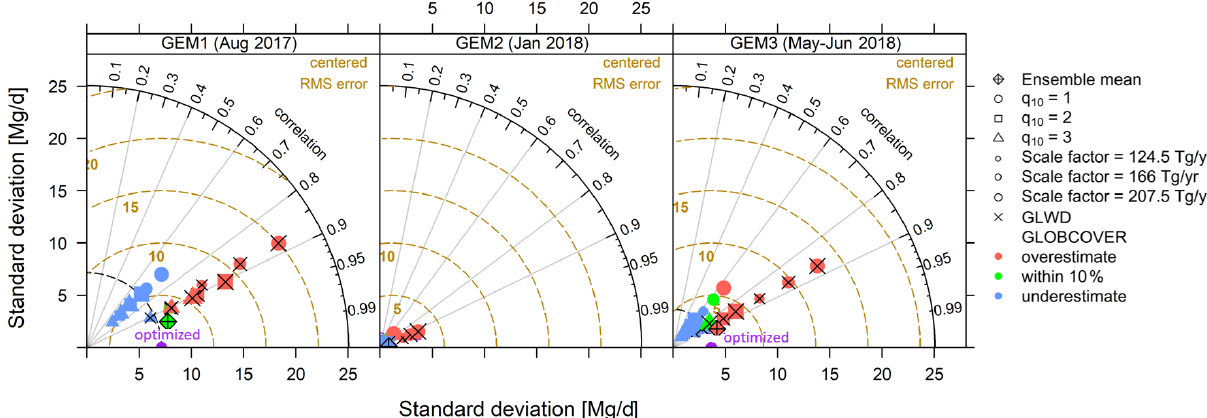
Figure 8. Taylor diagram evaluating the performance of Upper Midwest wetland emission estimates from the WetCHARTs inventory against the optimized fluxes derived here. The colored symbols show the 18 WetCHARTs extended ensemble members, which feature three tempera- ture sensitivity factors (CH 4 :C q 10 = 1, 2, or 3); three scale factors to obtain global emissions of 124.5, 166, or 207.5Tg/yr; and two wetland extent datasets (GLOBCOVER and GLWD, marked with open symbols and crosses, respectively). Symbols are colored by flux magnitude relative to the optimized emissions. Three statistics are shown in these plots: (1) the slope between each symbol and the origin reflects the spatial correlation between that model and the optimized emissions; (2) the distance between each symbol and the origin reflects the standard deviation of that model estimate; and (3) the distance between each symbol and the optimized value reflects the centered root-mean-square error of that model estimate relative to the optimized solution. Optimized results correspond to the multi-inversion ensemble